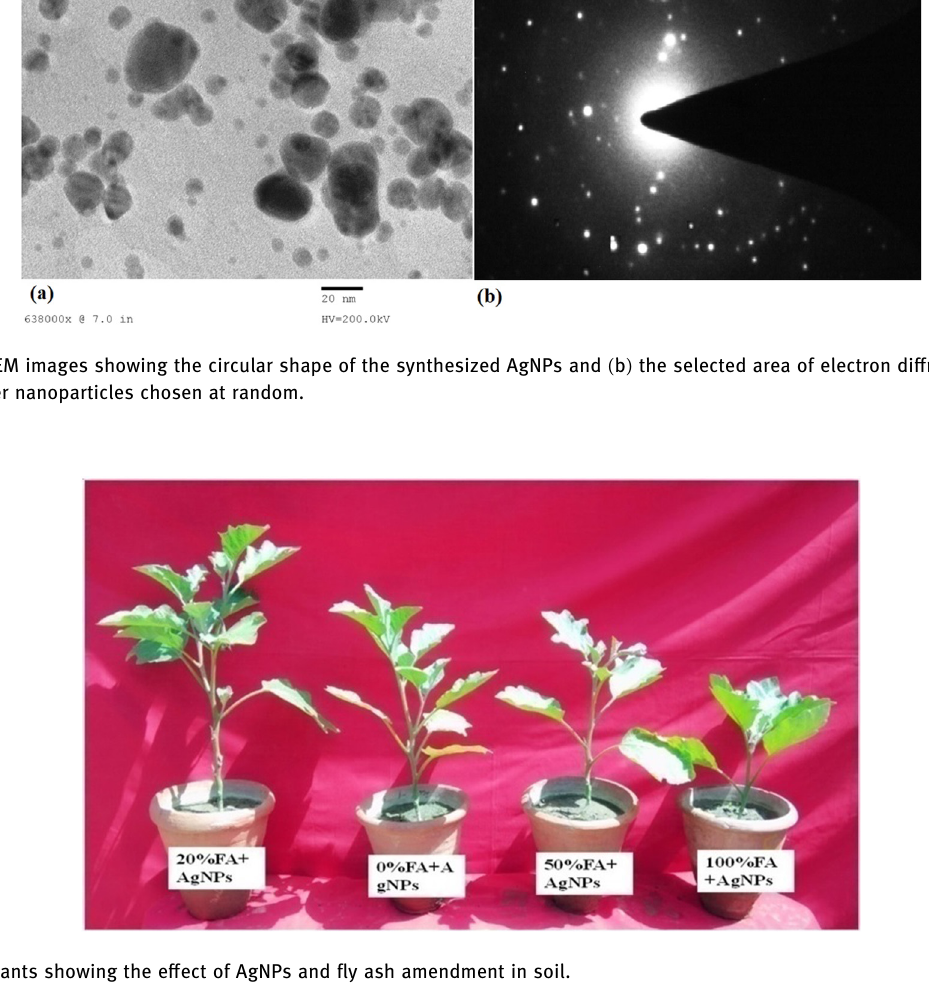
Figure 7: Eggplants showing the e ff ect of AgNPs and fl y ash amendment in soil.